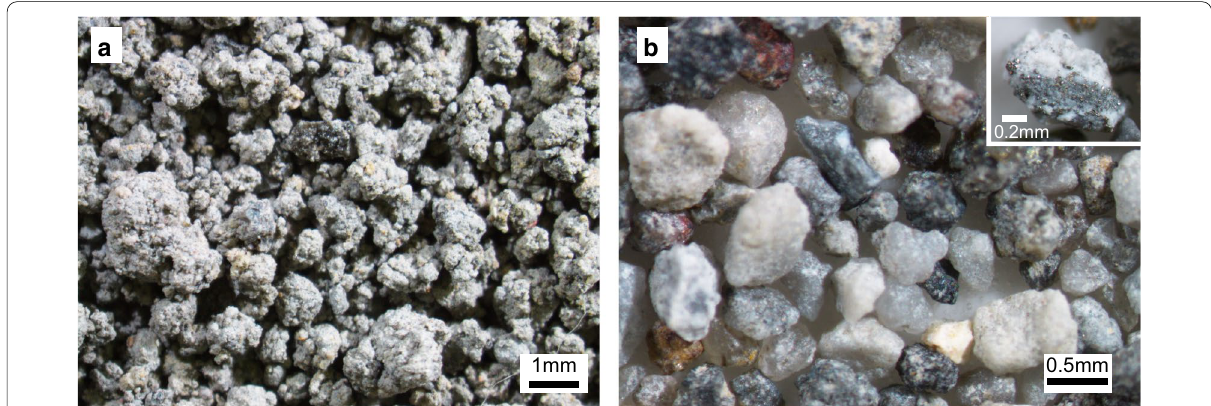
Fig. 5 Photomicrograph (binocular) of primary tephra (KSs-02); a aggregates of mineral grains and lithic fragments coated by mud, b washed samples (mud fraction removed) consisting of mineral grains and lithic (some hydrothermally altered) fragments. Inset figure shows fine grained pyrite coherent with a white-colored lithic